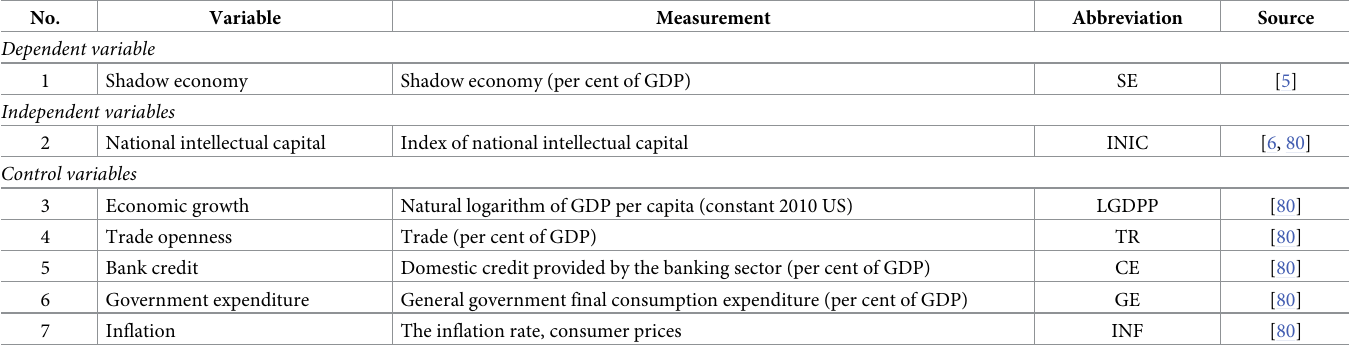
Table 1. Description of variables and